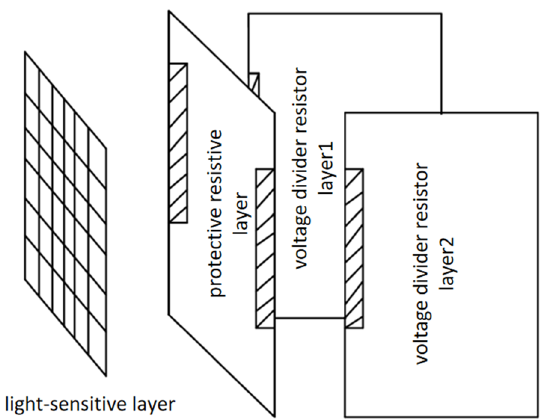
Figure 8. Installation design of the three-state optical signal detector.